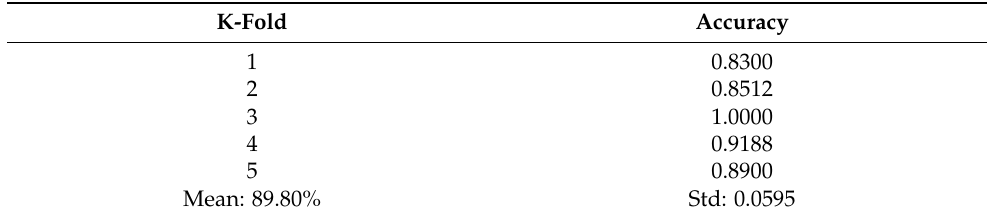
Table 3. Accuracies achieved by performing five-Fold cross-validation on the CNN solver model based on the original